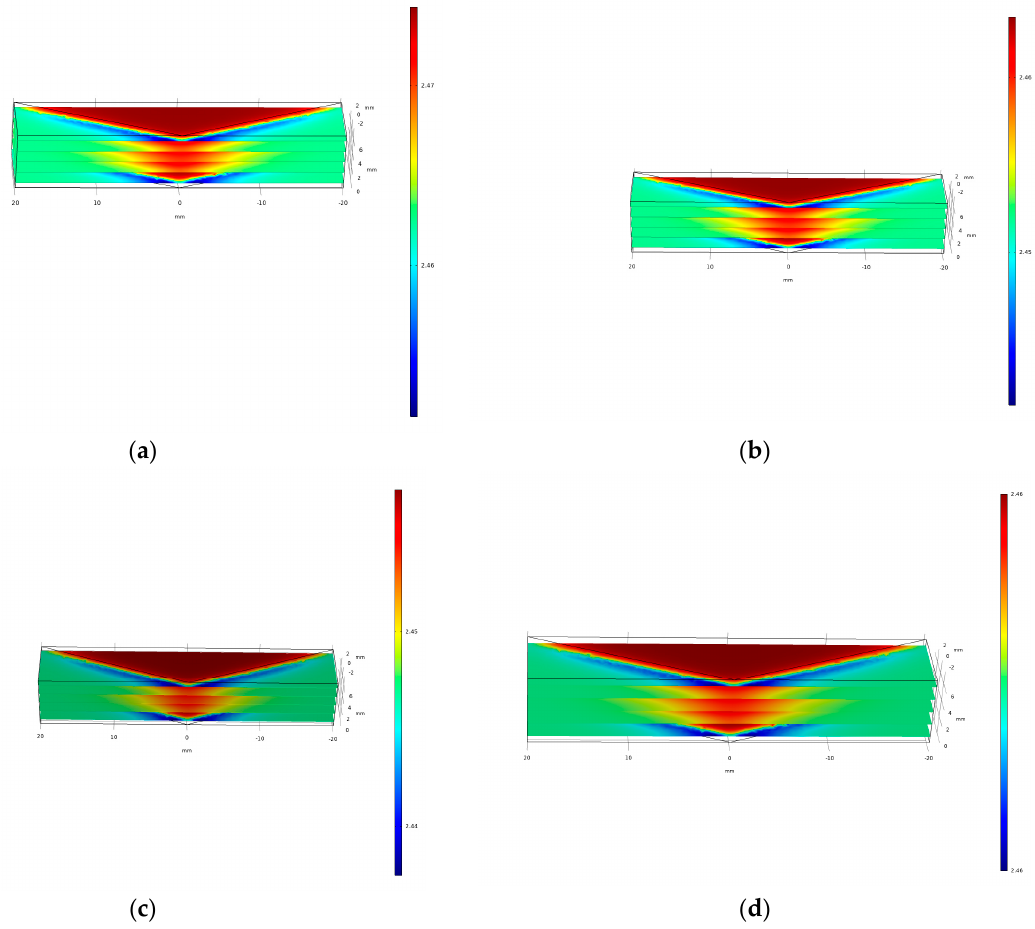
Figure 21. The birefringence simulation of the EO steerer based on PMN-PT ceramic under 1 kV/mm at 25 °C using a COMSOL model for ( a ) 532 nm, ( b ) 633 nm, ( c ) 1550 nm, and ( d ) 4500 nm.